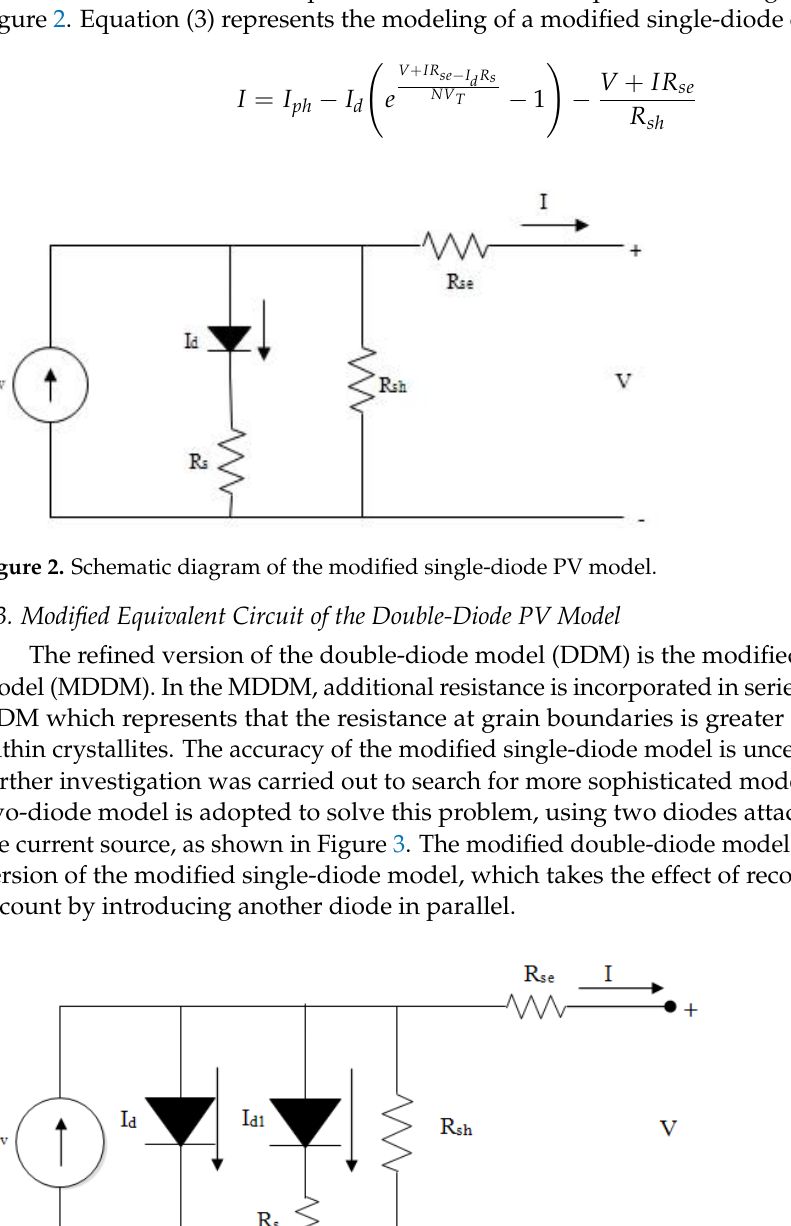
Figure 1. Equivalent circuit of an ideal solar PV cell.